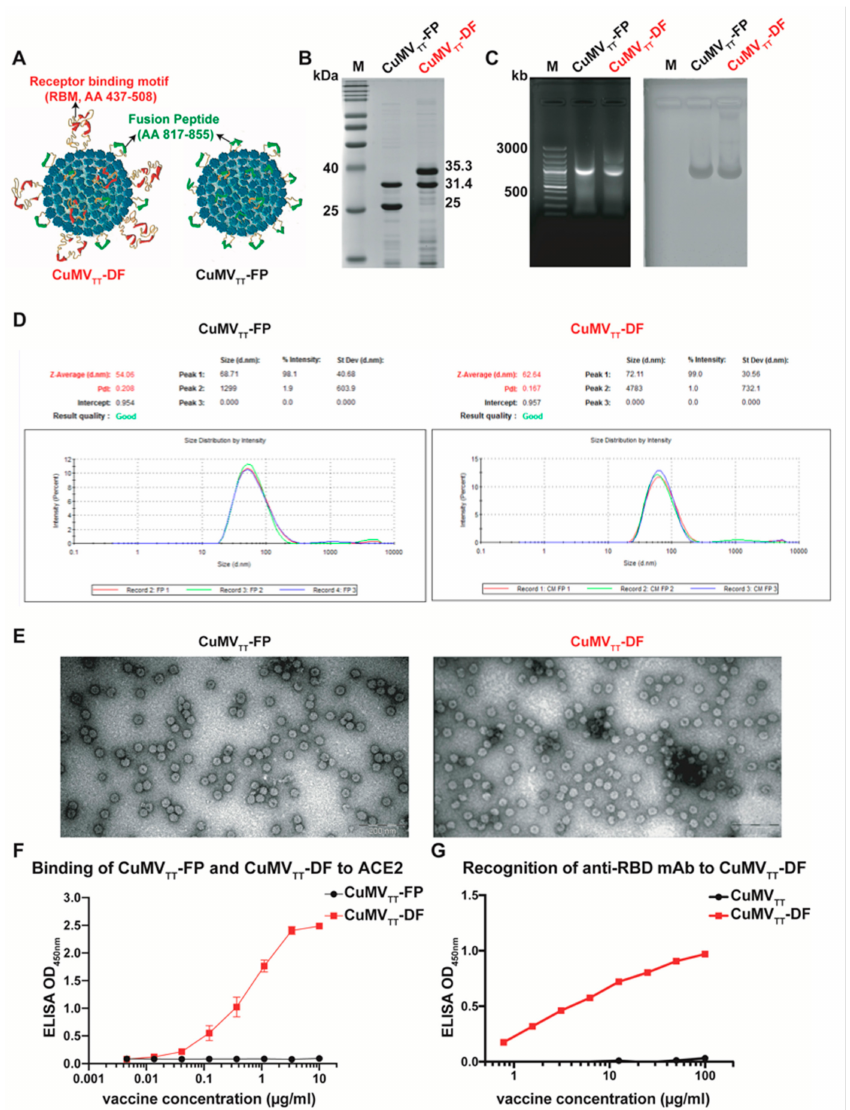
Figure 1. Characterization of CuMV TT -FP and CuMV TT -DF vaccines. ( A ): Design illustrations of CuMV TT -FP and CuMV TT -DF vaccines; ( B ): Analysis of purified CuMV TT -FP and CuMV TT -DF vaccine on SDS-PAGE gel; ( C ): Analysis of prokaryotic RNA incorporated in CuMV TT -FP and CuMV TT -DF VLPs on agarose gel, which was recorded under UV light (left) and afterwards, stained with Coomassie blue (right); ( D ): Determination of size distribution of CuMV TT -FP and CuMV TT -DF vaccine particles with dynamic light scattering; ( E ): Transmission electron microscopy analysis of CuMV TT -FP and CuMV TT -DF vaccines; ( F ): Binding of CuMV TT -FP and CuMV TT -DF vaccines to ACE2 receptor assessed by Sandwich ELISA; duplicates were performed. ( G ): Binding of anti-RBD monoclonal antibody to CuMV TT -DF vaccine assessed by Sandwich ELISA. OD 450nm are displayed for serially diluted vaccine